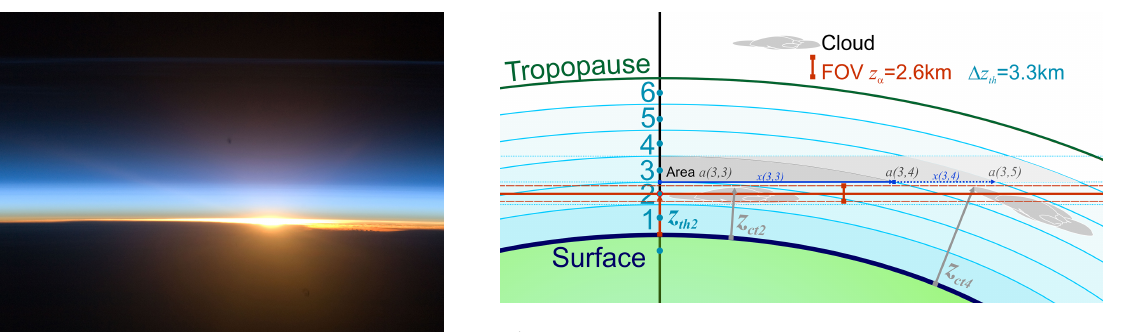
Figure 2. Schematic view of the limb measurement geometry. The shells are numbered from the surface to the tropopause (here 1 to 6). The field of view (FOV), the tangent height step width (cid:49)z th , and the cloud top height z ct are superimposed. Examples of shell path lengths x as blue lines and areas a (grey shaded) are shown. The limb path is a combination of the paths through each shell. The sub-paths x( 3 , 3 ) and x( 3 , 4 ) (blue line) are depicted belonging to shell 3. The first index stands for the original tangent height and the second index for the current shell of the path